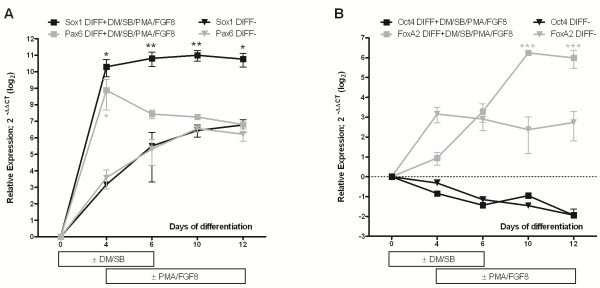
The utilization of dorsomorphin (DM) and SB 431542 (SB) in the hCBiPSCs differentiation process significantly improved neural conversion. Relative gene expression was measured by quantitative real-time PCR. (A) A marked increase in the expression of the neural stem cell markers Sox1 and Pax6 was observed during the first four days of differentiation by application of DM/SB (DIFF+) compared to cells differentiated without these molecules (DIFF-). (B) Downregulation of the pluripotency marker Oct4 was found as the maturation proceeded under both conditions. Midbrain regionalization, monitored by the expression of the midbrain marker FoxA2, was induced by PMA/FGF8 treatment (DIFF+) on day 4 of differentiation. A significantly higher FoxA2 level was observed in PMA/FGF8 treated cells compared to controls (DIFF-) from day 10 on. Values are calculated as means ± SEM. P-values (*P <0.05, **P <0.01, ***P <0.001) were determined using two-way ANOVA and Bonferroni posttest. ANOVA, analysis of variance; FGF8, fibroblast growth factor 8; hCBiPSCs, human cord blood induced pluripotent stem cells; PMA, purmorphamine; SEM, standard error of the mean.